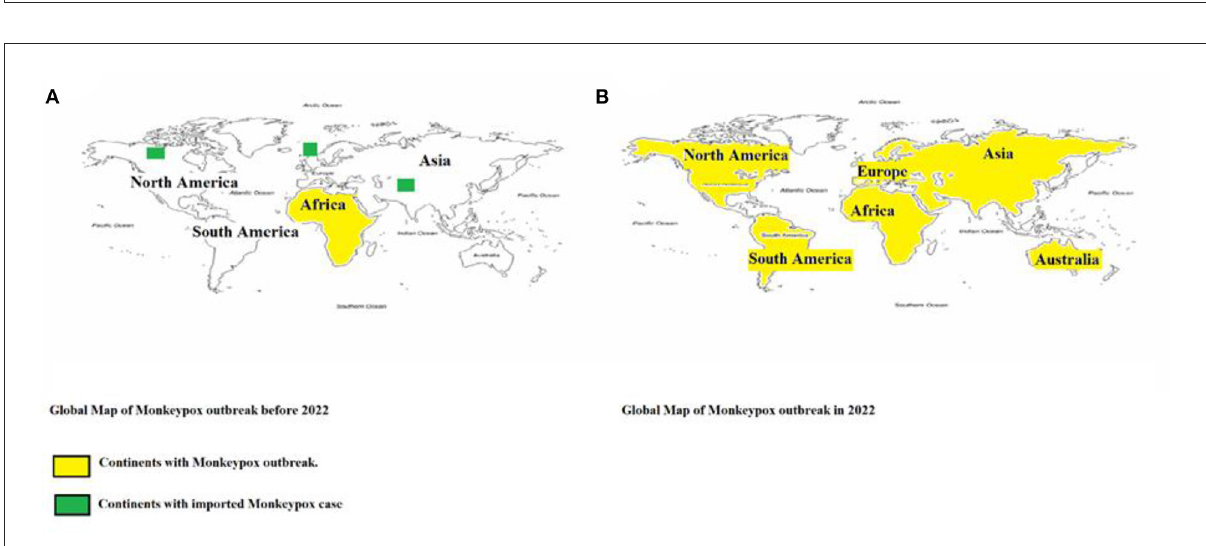
FIGURE3 Geographical distribution of confirmed cases of Monkeypox reported (A) before 2022 and (B) during 2022. Continents that reported cases are color-coded in yellow, while the continents with imported cases are highlighted in